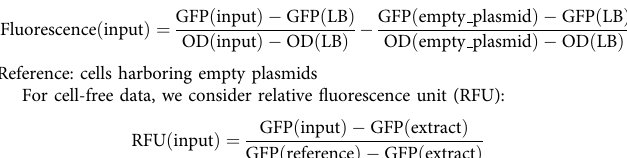
Cell-free extract and buffer preparation . Cell-free E. coli extract was produced using published methods 52,69,70 . Brie fl y, an overnight culture of BL21 Star (DE3):: RF1-CBD 3 E. coli was used to inoculate 4 L of 2xYT-P media in six 2 L fl asks at a dilution of 1:100. The cultures were grown at 37 °C with 220 rpm shaking for ~3.5 – 4h until the OD 600 = 2 – 3. Cultures were centrifuged at 5000 × g at 4°C for 12min. Cell pellets were washed twice with 200 mL S30A buffer (14 mM